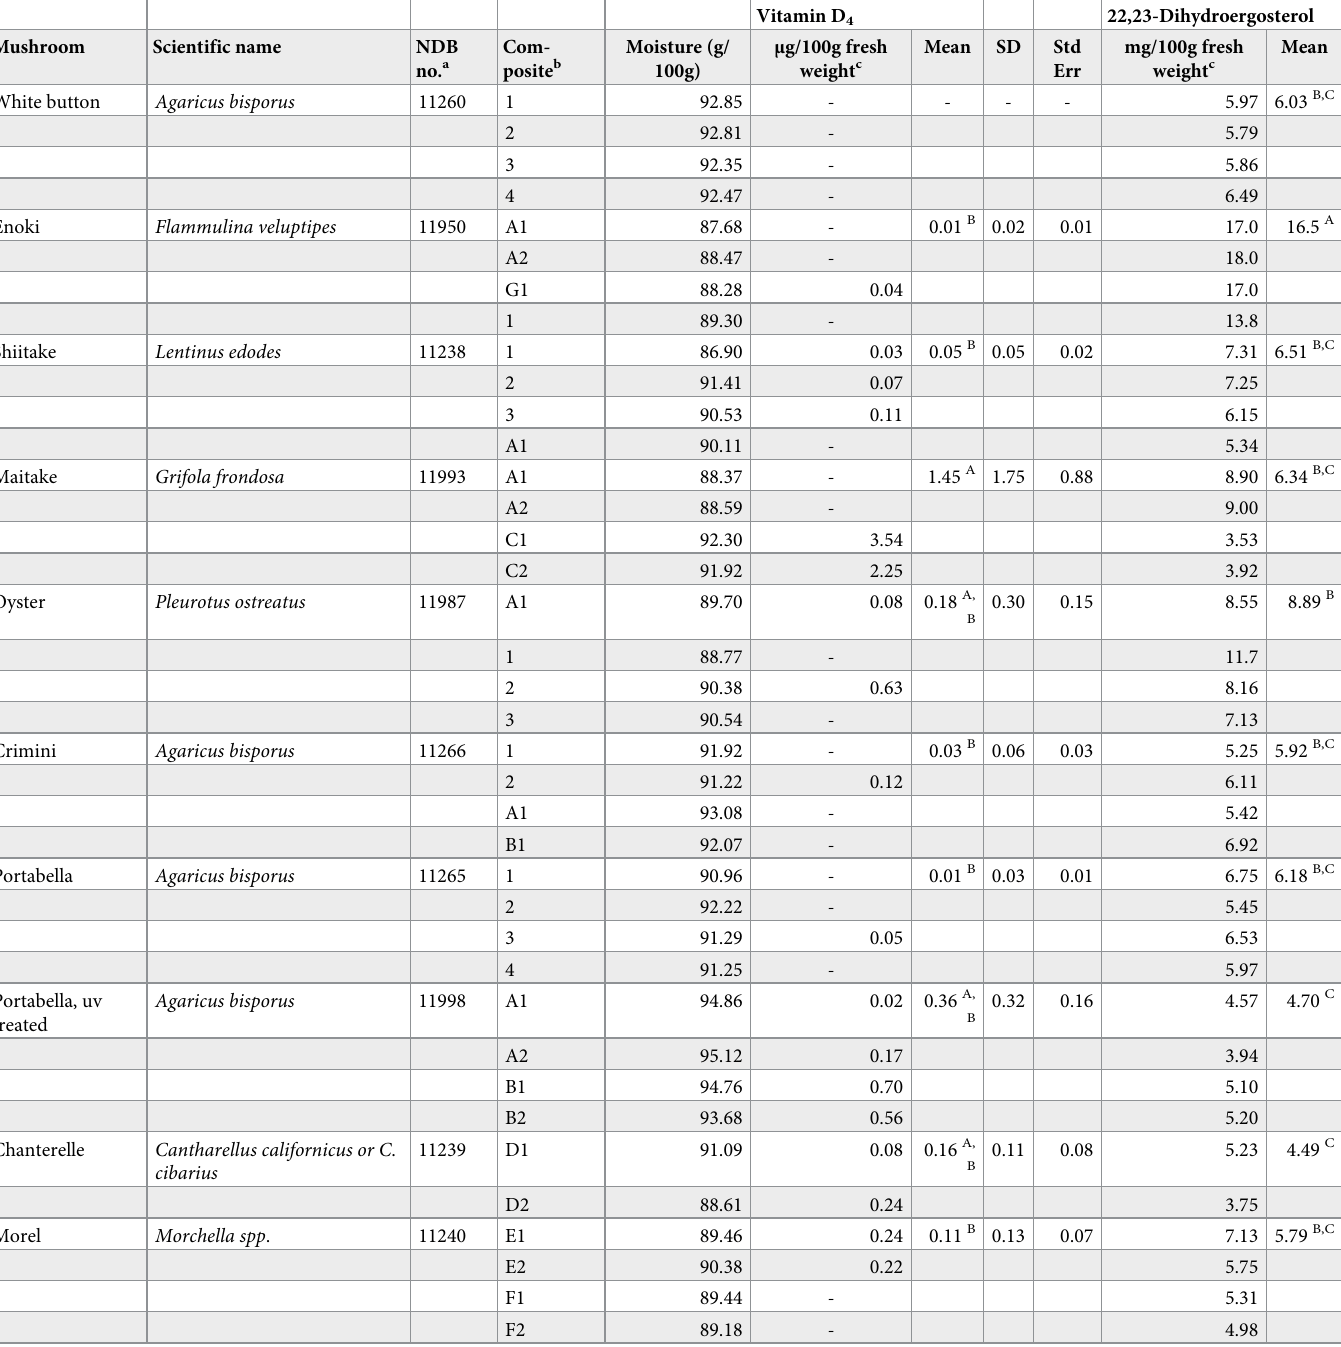
Table 1. Vitamin D 4 and pro-vitamin D 4 (22,23-dihydroergosterol; ergosta-5,7-dienol) content of ten types of mushrooms. Vitamin D 4